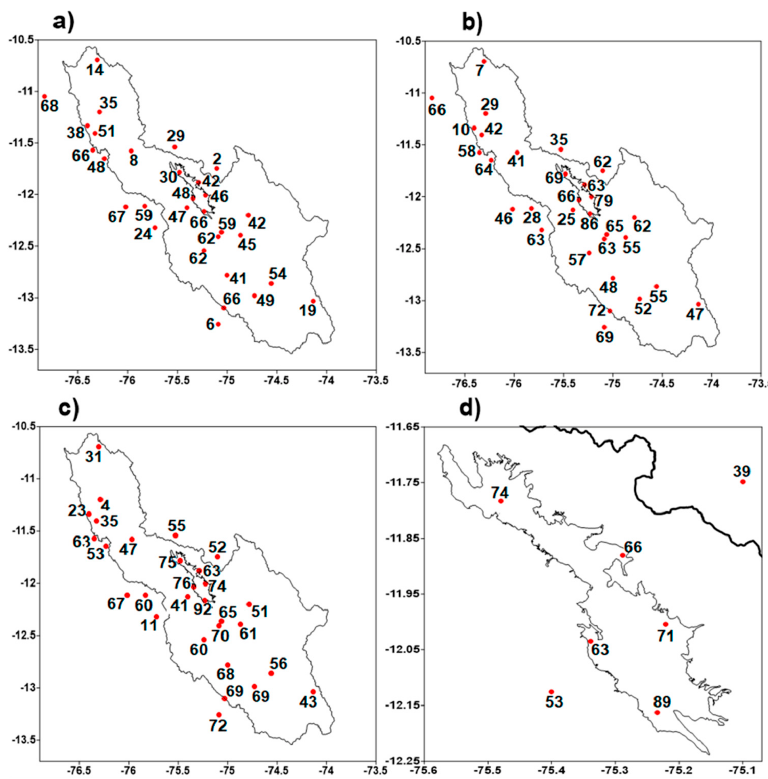
Figure 12. Spatial distribution of bias (%) for results with domains D1 ( a ), D2 ( b ), D3 ( c ), and D4 ( d ). The numbers above the circles indicate the percentage of underestimation. Table 3. Statistics of verification for the 4 simulated domains, average of all stations. In parentheses are the percentages of underestimation.